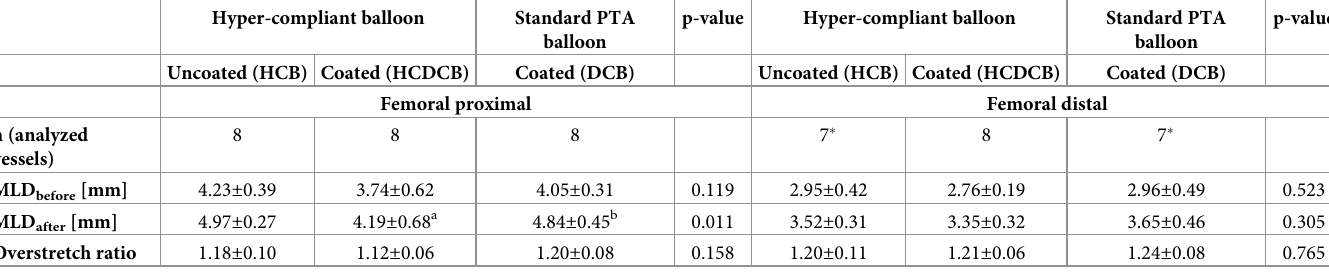
Table 3. Quantitative angiography (QA) of each vessel segment of femoral arteries before and after intervention.